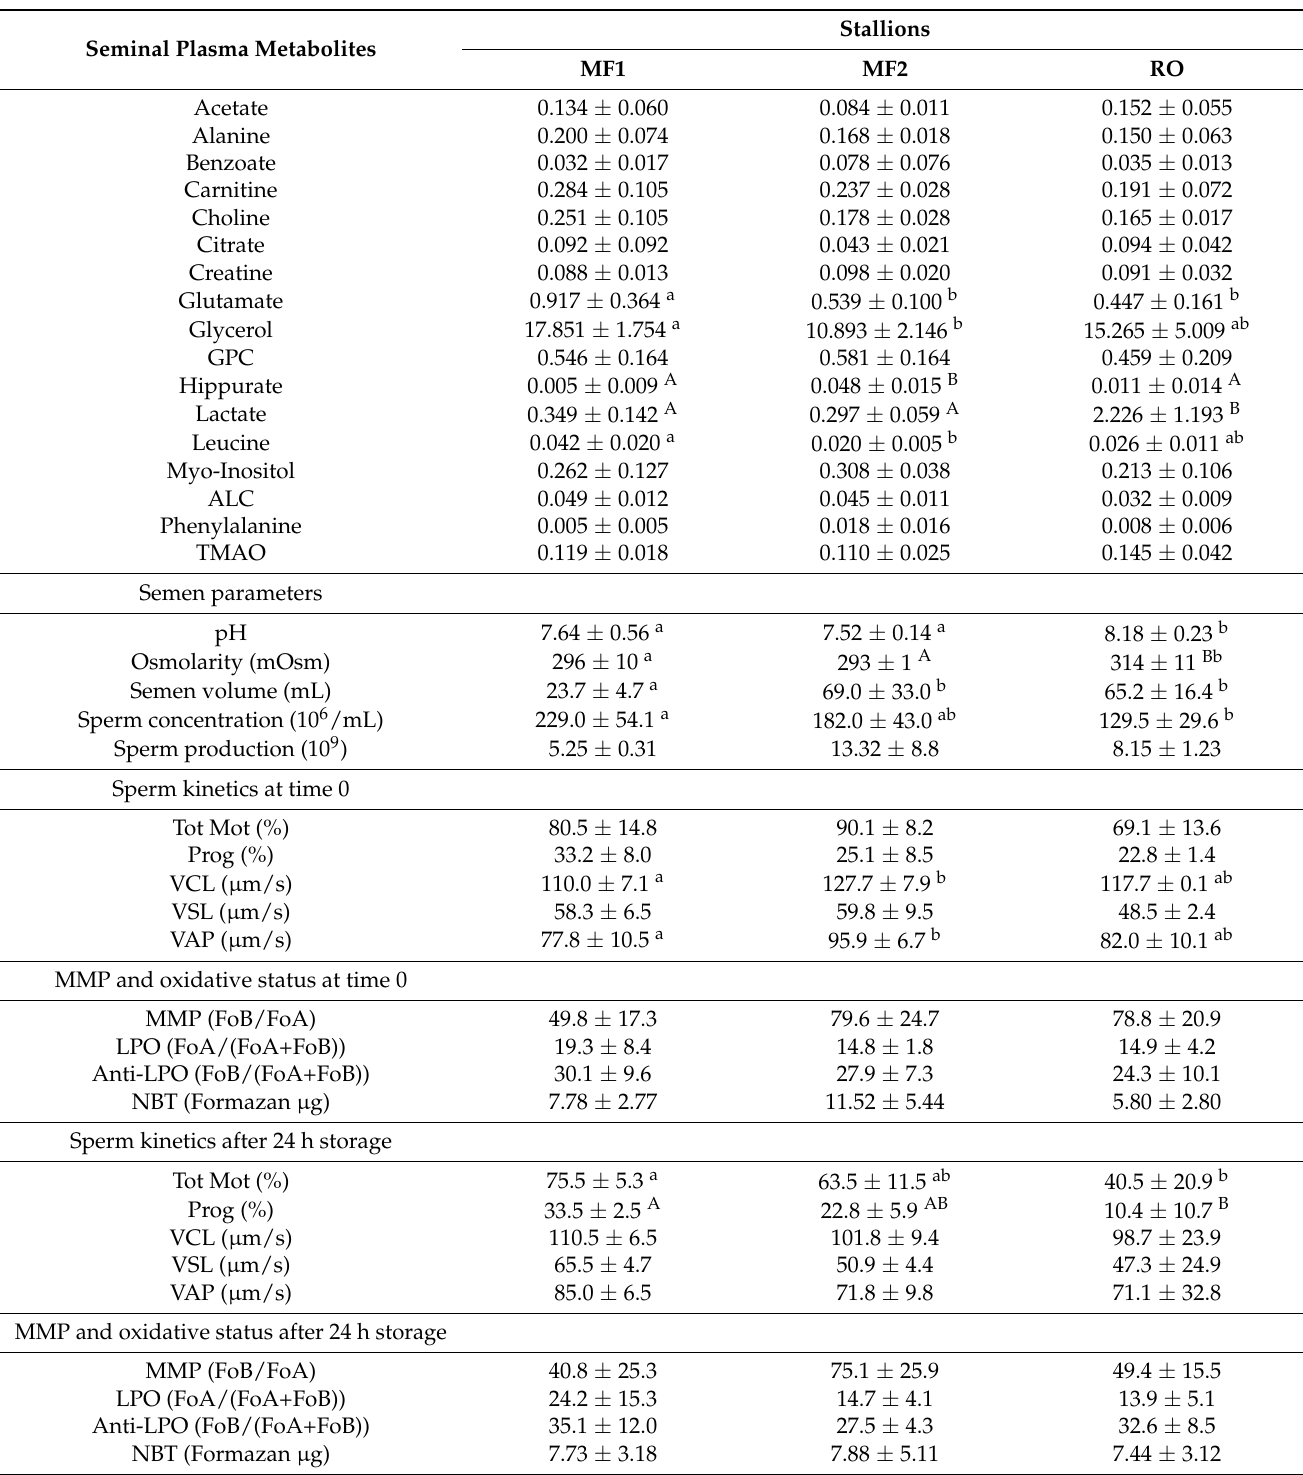
Table 2. Mean ( ± SD) values of seminal plasma metabolites (mM), semen parameters, sperm kinetics, mitochondrial membrane potential (MMP) and oxidative status recorded in the three donkey stallions (MF1, MF2 and RO) submitted to three sperm collections repeated on a monthly